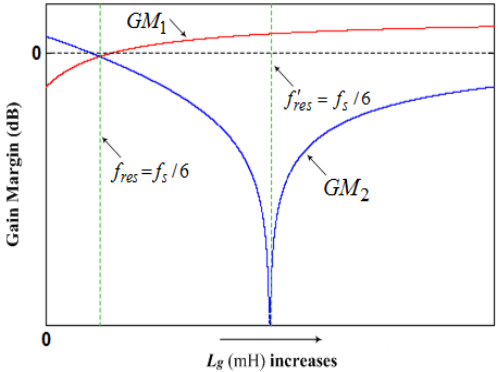
Figure 13. Curves of gain margins ( GM 1 and GM 2 ) with the increase of L g .